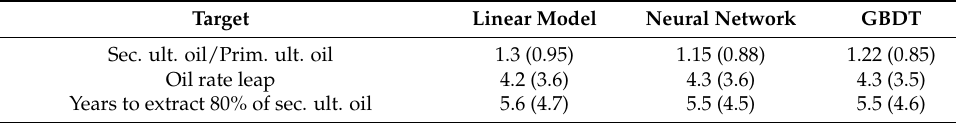
Table 5. ML models MAE on five-fold cross-validation. Metrics on training data in brackets.